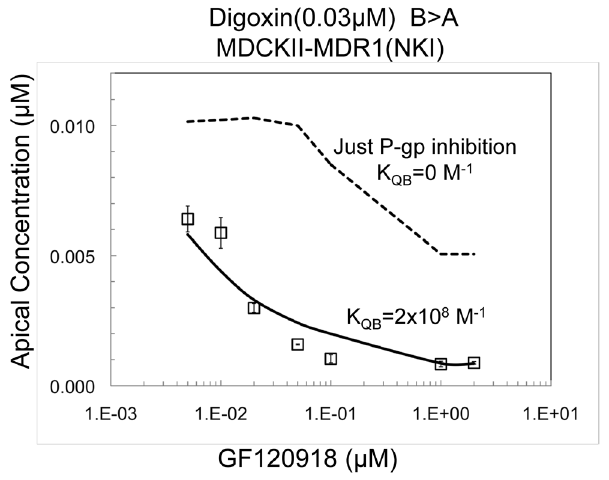
Figure 3. Inhibition of 0.03 mmmm M digoxin B . A transport at 2 hr across the MDCK-MDR1-NKI cell monolayer with increasing concentrations of GF120918, data acquired at GSK. Data shown are the average of triplicates, with standard deviation error bars. The dashed line shows the predicted inhibition when GF120918 only binds to P-gp, i.e. not to the basolateral digoxin uptake transporter. The solid line shows the fit when GF120918 binds to P-gp and the basolateral digoxin uptake transporter. K QB is the effective association constant of GF120918 to the basolateral digoxin uptake transporter defined by Eq. (3), Table 3. K QB combines the uptake transporter surface density, the binding constant of the inhibitor to the uptake transporter and, if the inhibitor accesses the binding site from the membrane, the inhibitor partition coefficient. other kinetic parameters were fixed by the values in Table 2. The fit is reasonable.